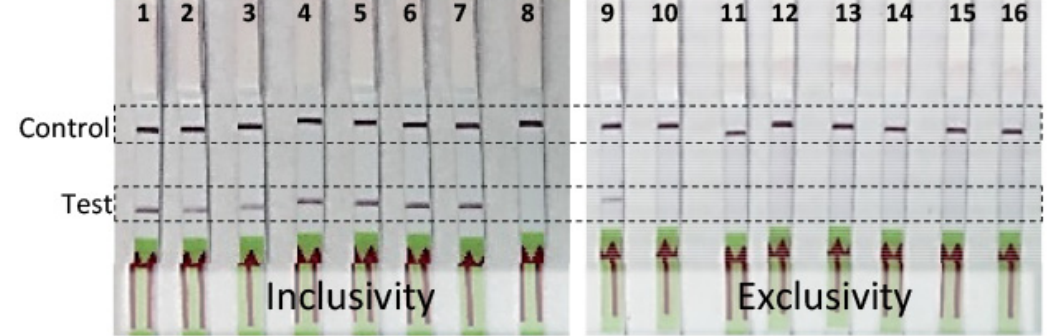
Figure 2. Validation of a Rathayibacter toxicus -specific recombinase polymerase amplification (RPA) assay with inclusivity and exclusivity panels; panel details are provided in Table 1. RPA amplification products were visualized with lateral flow strips. The upper bands on the lateral flow strips are the internal lateral flow strip control, the lower bands are the RPA reaction products. Lanes 1–8 (inclusivity panel results): 1— R. toxicus (SA03-04, RT-I); 2— R. toxicus (SA08-08, RT-I); 3— R. toxicus (SA19-02, RT-I); 4— R. toxicus (CS14, RT-II); 5— R. toxicus (CS28, RT-III); 6— R. toxicus (CS33, RT-II); 7— R. toxicus (CS34, RT-II); 8—water (non-template control). Lanes 9–16 (exclusivity panel results): 9— R. toxicus (SA08-08, positive control); 10— R. tritici (WAC7055); 11— R. agropyri (WAC9621); 12— R. iranicus (ICMP 3494); 13— R. rathayi (ICMP 2574); 14— Dietzia cinnamea (SA03-14M); 15— Clavibacter michiganensis subsp. nebraskensis (Cmn); 16—water (non-template